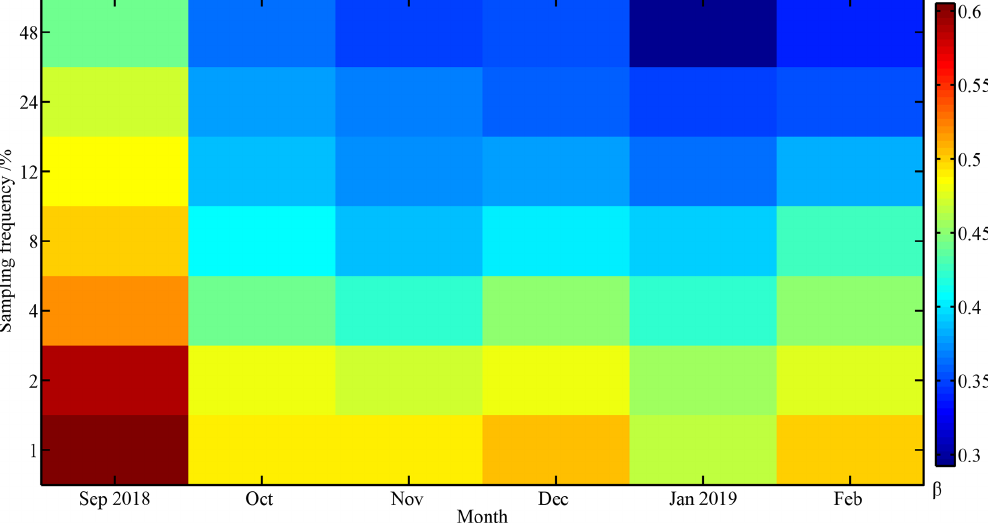
Figure 13. Changes in monthly spatial scaling exponent as a function of position data resampling frequency obtained from the CHINARE buoy